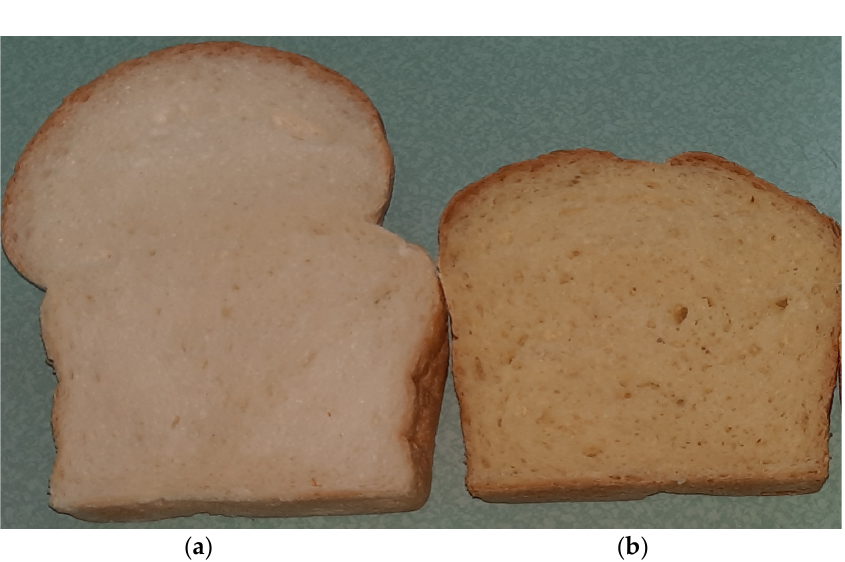
Figure 5. Winter wheat and Trititrigia baked in laboratory conditions: ( a ) winter wheat “Stanichnaya” and ( b ) Trititrigia “Pamyati Lyubimovoy”.